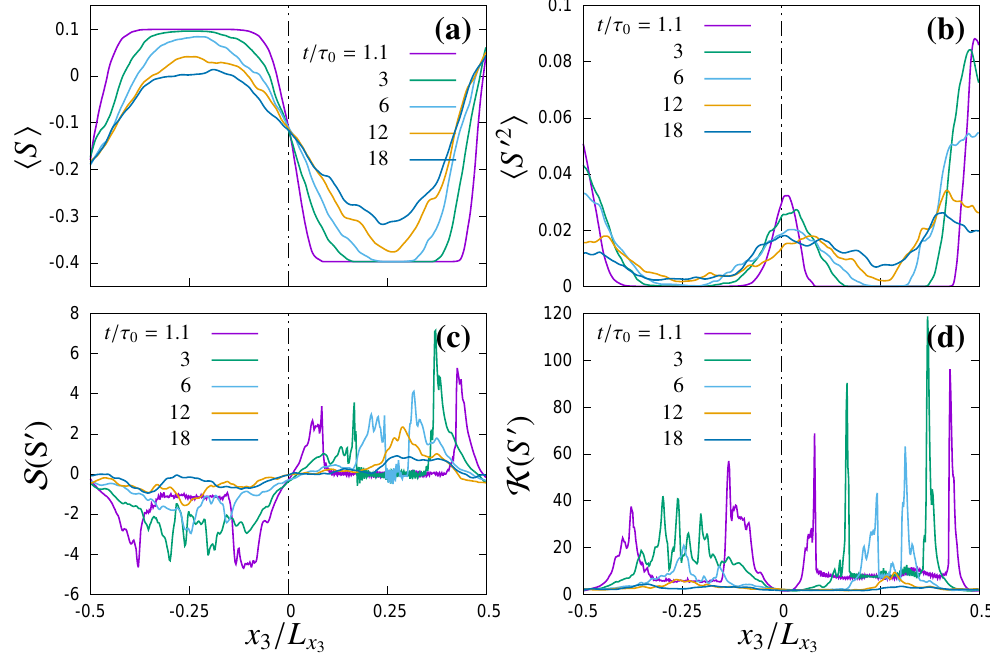
S S (cid:48) 2 ; ( b ) variance ; (cid:104) (cid:105) (cid:104) (cid:105)